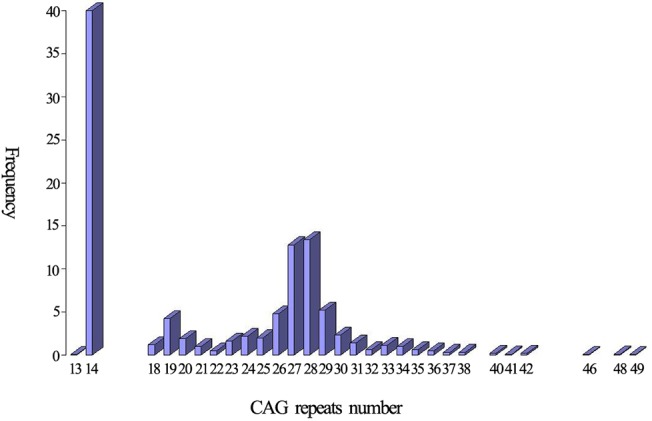
The distribution of the CAG repeats in 2006 wild-type chromosomes.